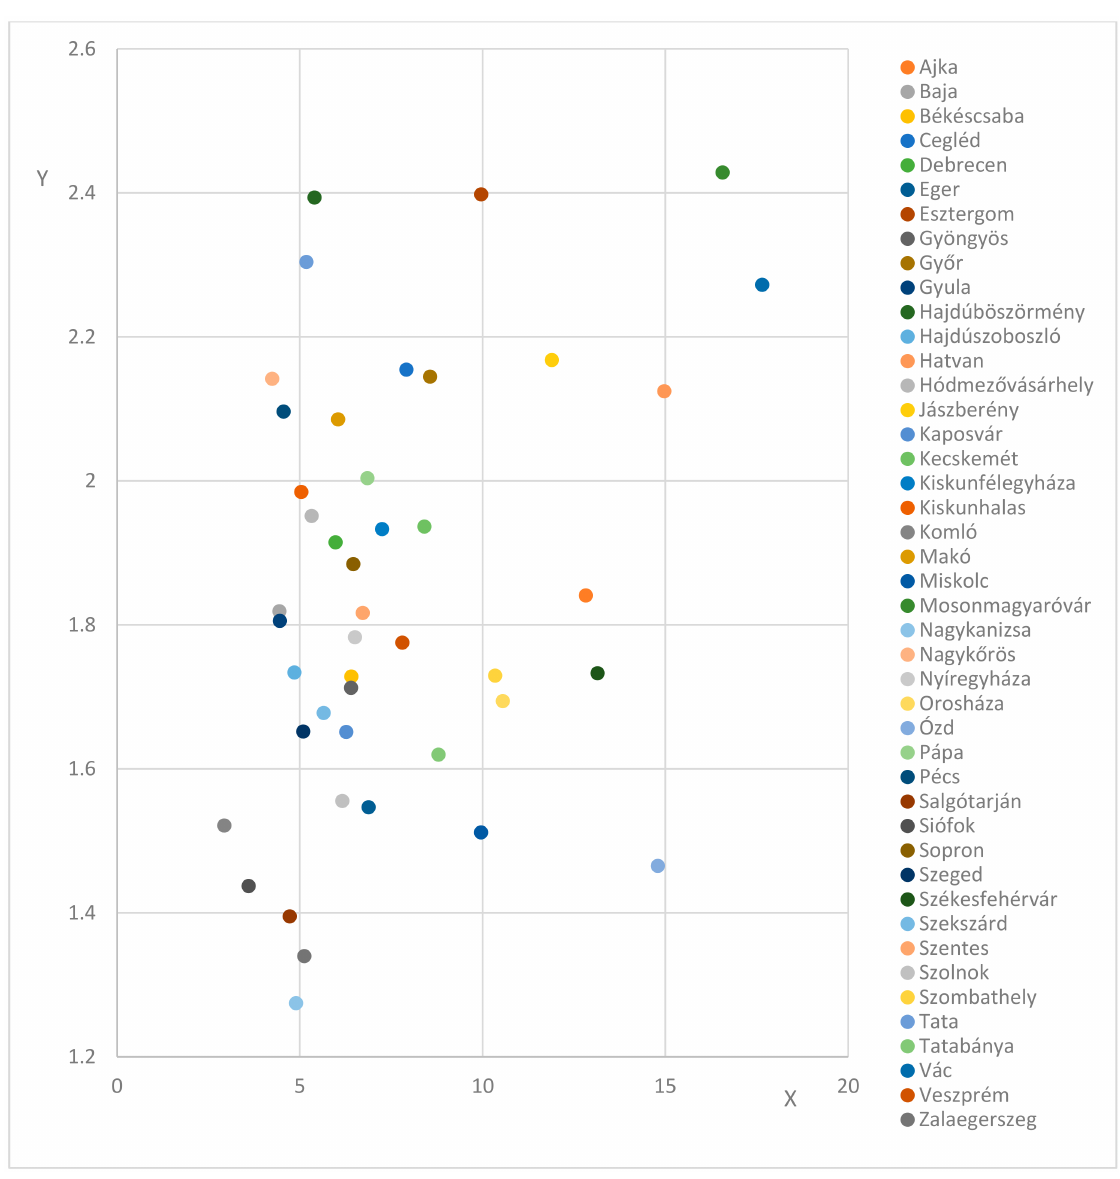
Figure 4. The amount of electrical energy provided to households yearly based on amount/person and city size. Legend: Axle Y = The amount of electricity provided to households (1000 kWh/ household) Axle X = Size (km 2 ) ( n =